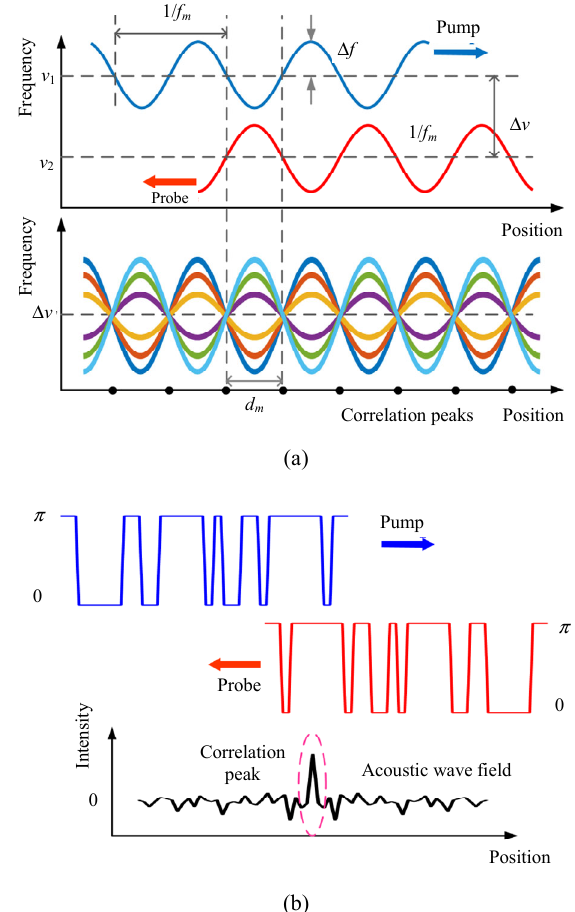
Fig. 4 Operation principle of BOCDA: (a) frequency modulation and (b) phase modulation